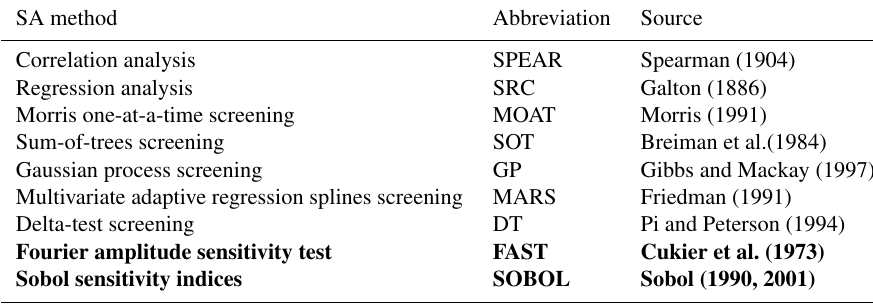
Table 2. Sensitivity analysis methods. Qualitative methods in black font. Quantitative methods in bold font.